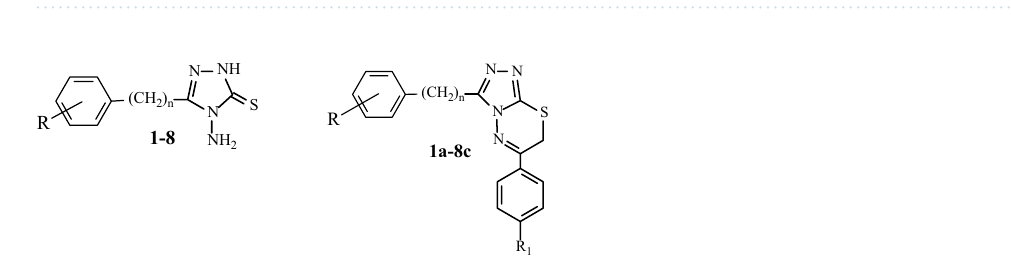
Figure 1. Structures of anastrozole, letrozole, and vorozole used in treatment of estrogen receptor positive breast cancer as nonsteroidal aromatase inhibitors.